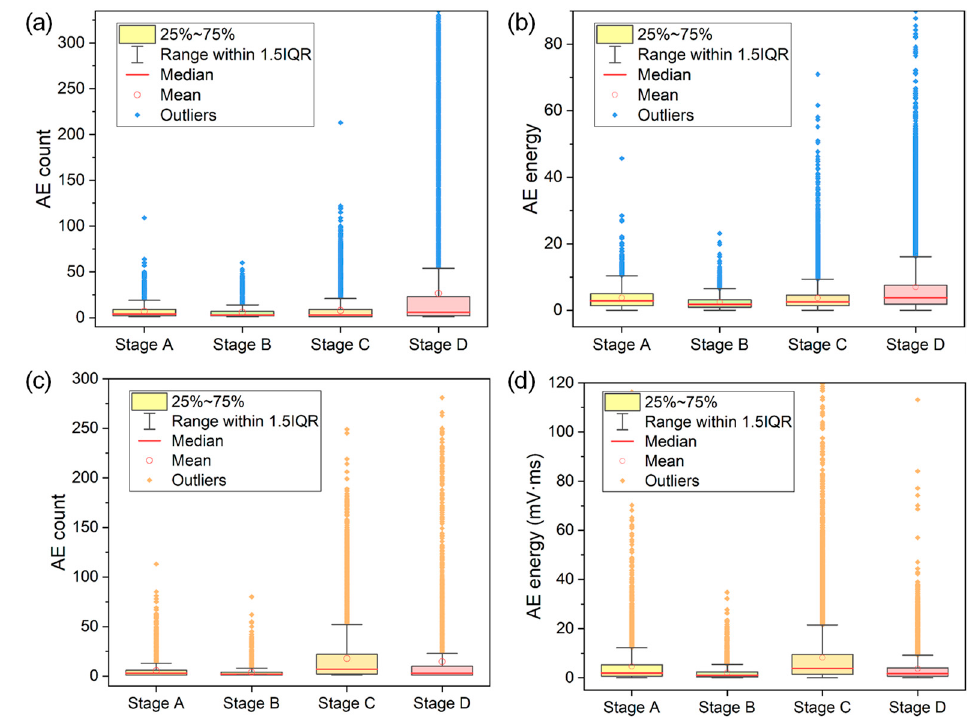
Figure 8. The distributions of ( a , c ) AE count and ( b , d ) energy in four stages of FCG of specimen ( a , b ) No. 1 and ( c , d ) No. 2. The colored regions represent the middle 50% of values, that is, the range between the 25% and 75% percentile. The range between the top and bottom lines is 1.5 times the interquartile range